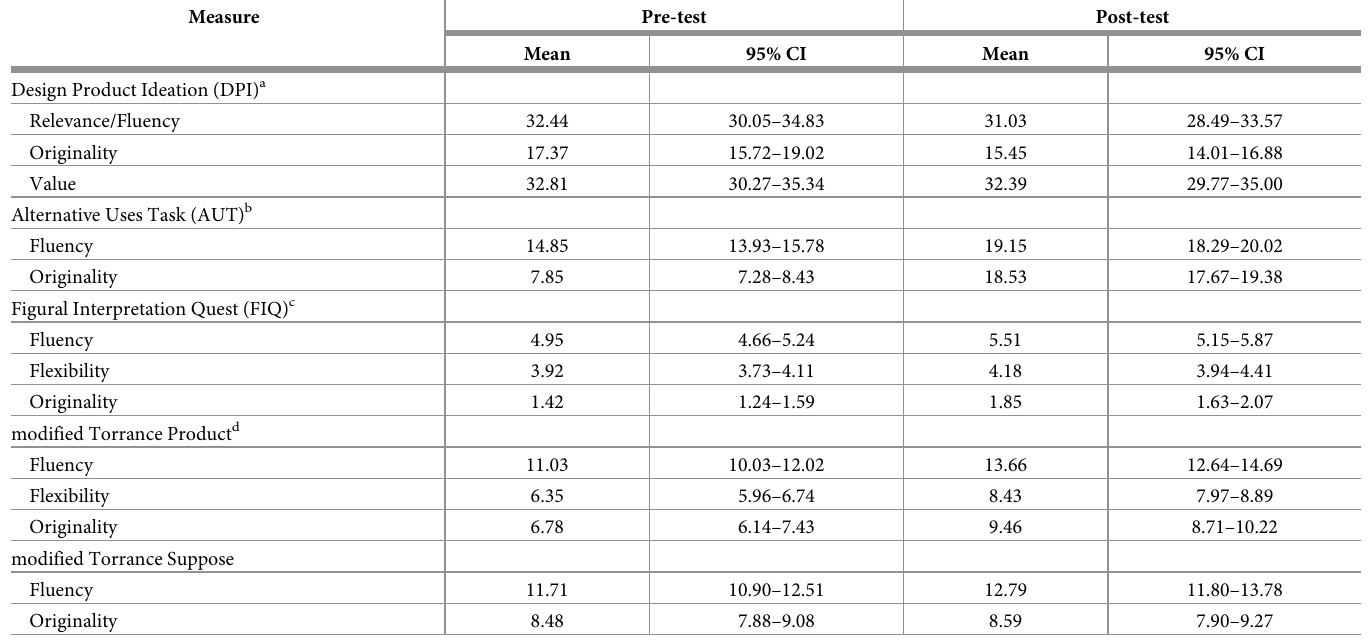
Table 4. Descriptive statistics for the creative performance